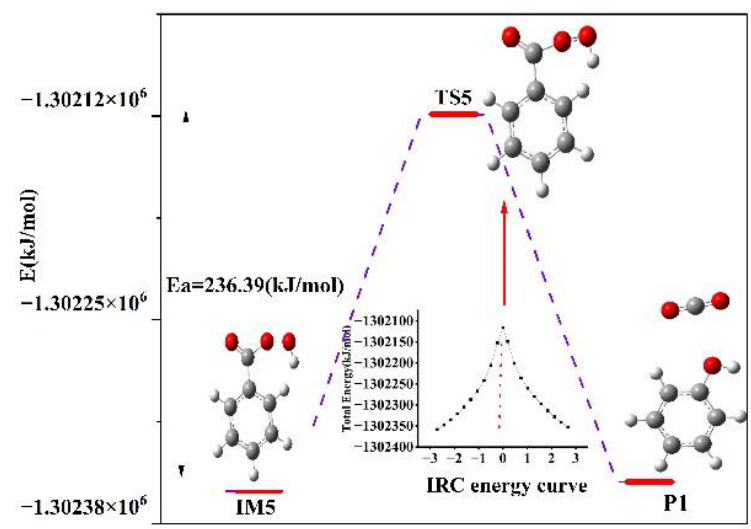
Figure 6. Activation energy of CO 2 formed by the methyl group.